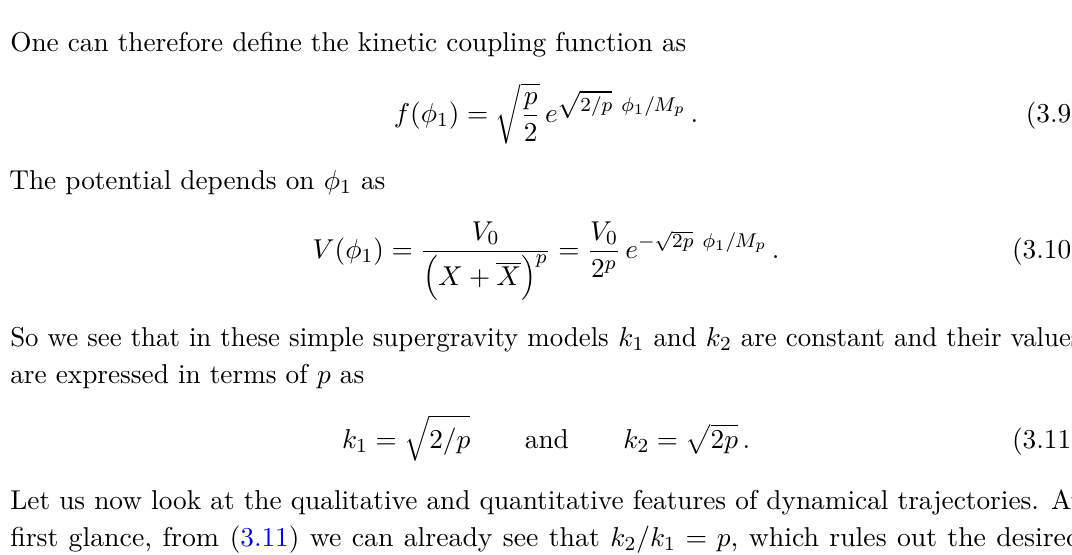
Figure 1 . Dynamical trajectories in the ( ω, Ω) plane for stringy models with k 1 and k 2 specified by (3.11). Left: initial condition are chosen to be matter domination. None of the trajectories go through the black dot representing the correct current value for late time observables. Right: the trajectories are required to pass through the observed current values of ( ω, Ω)